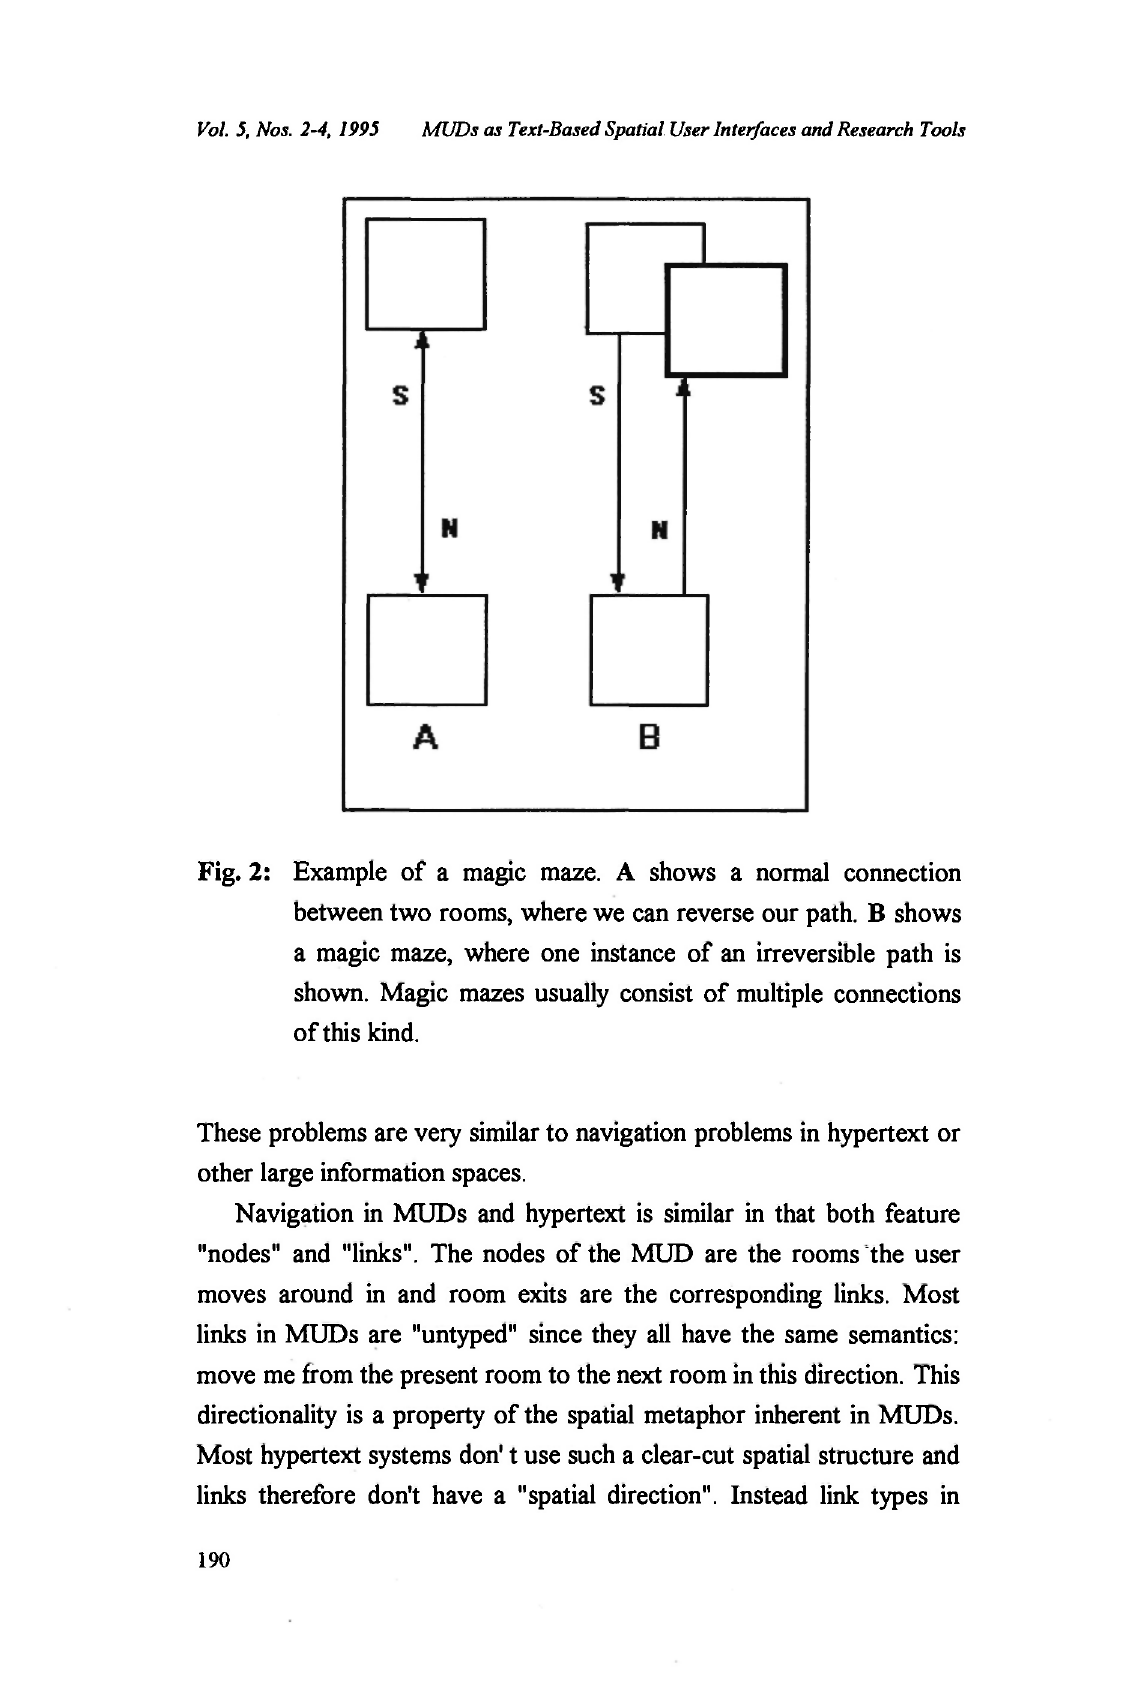
Fig. 2: Example of a magic maze. A shows a normal connection between two rooms, where we can reverse our path. Β shows a magic maze, where one instance of an irreversible path is shown. Magic mazes usually consist of multiple connections of this